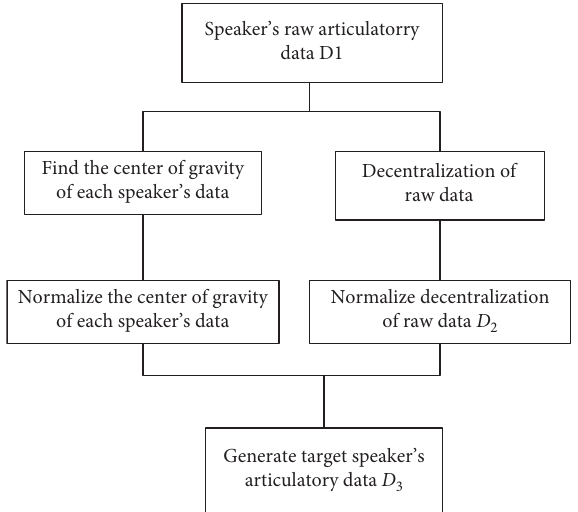
Figure 2: Diagram of speaker normalization algorithm based on Prussian